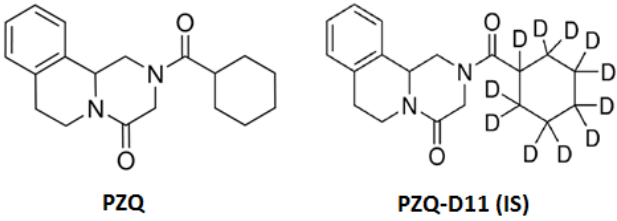
Figure 1. Chemical structures of praziquantel (PZQ) and internal standard (IS)